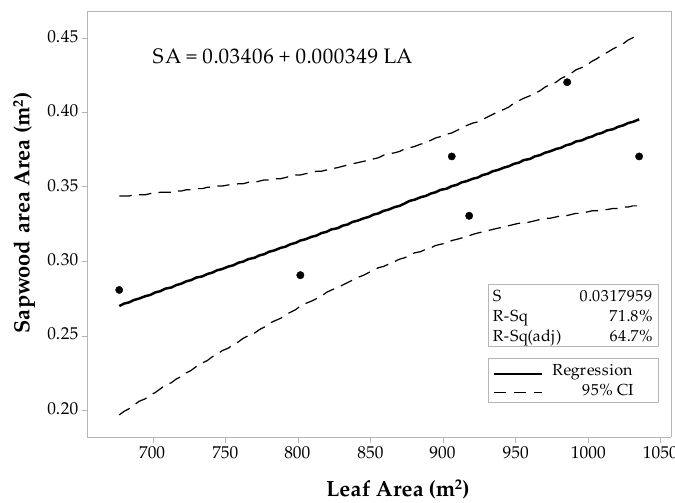
Figure 5. Fitted linear regression model for the 10 × 10 m stands of conifers, SA plot in relation to its LA plot .